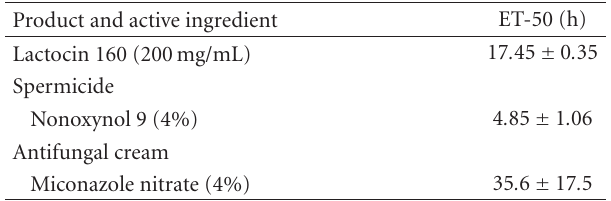
Table 1: ET-50 values of products using the EpiVaginal tissue model (mean ± standard